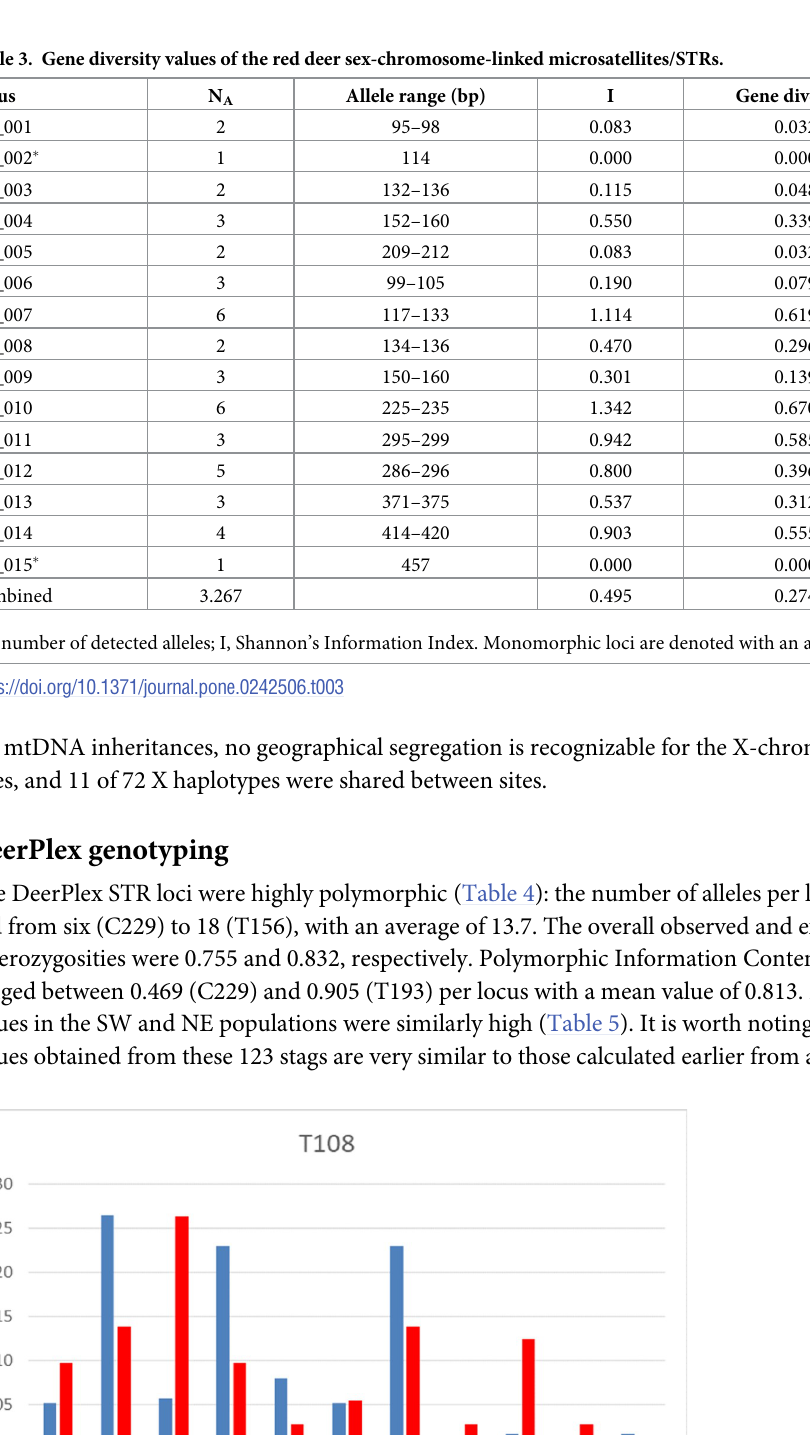
Table 3. Gene diversity values of the red deer sex-chromosome-linked microsatellites/STRs. Locus N A Allele range (bp)